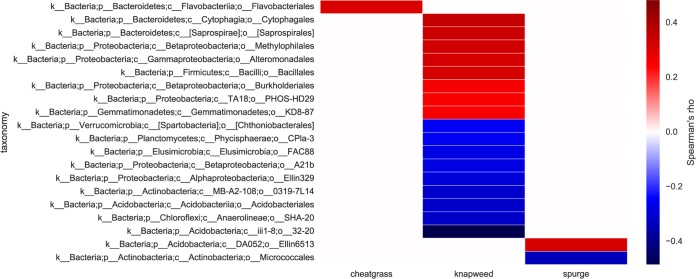
Heatmap showing Spearman’s rho values for significant correlations between weed abundances and bacterial classes (i.e., OTU data pooled at the class level; FDR-corrected P < 0.05). There were no bacterial classes that showed significant correlations with more than one weed species.